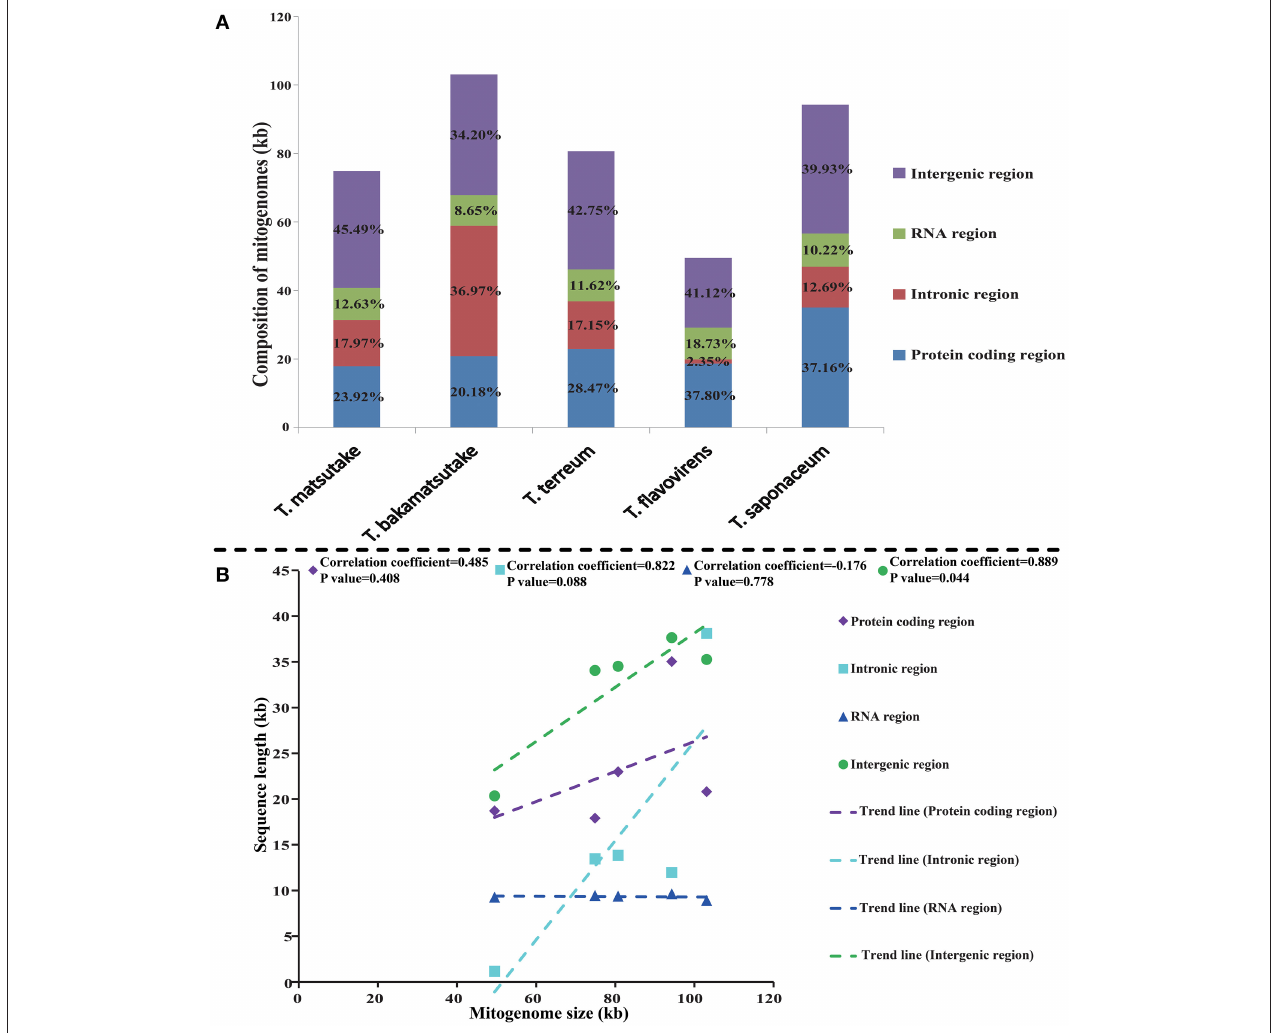
FIGURE 2 | The protein-coding, intronic, intergenic, and RNA gene region proportions of the entire mitochondrial genomes of the five Tricholoma species (A) and pearson correlation analysis between mitogenome sizes and sequence lengths of 5 Tricholoma species (B) .